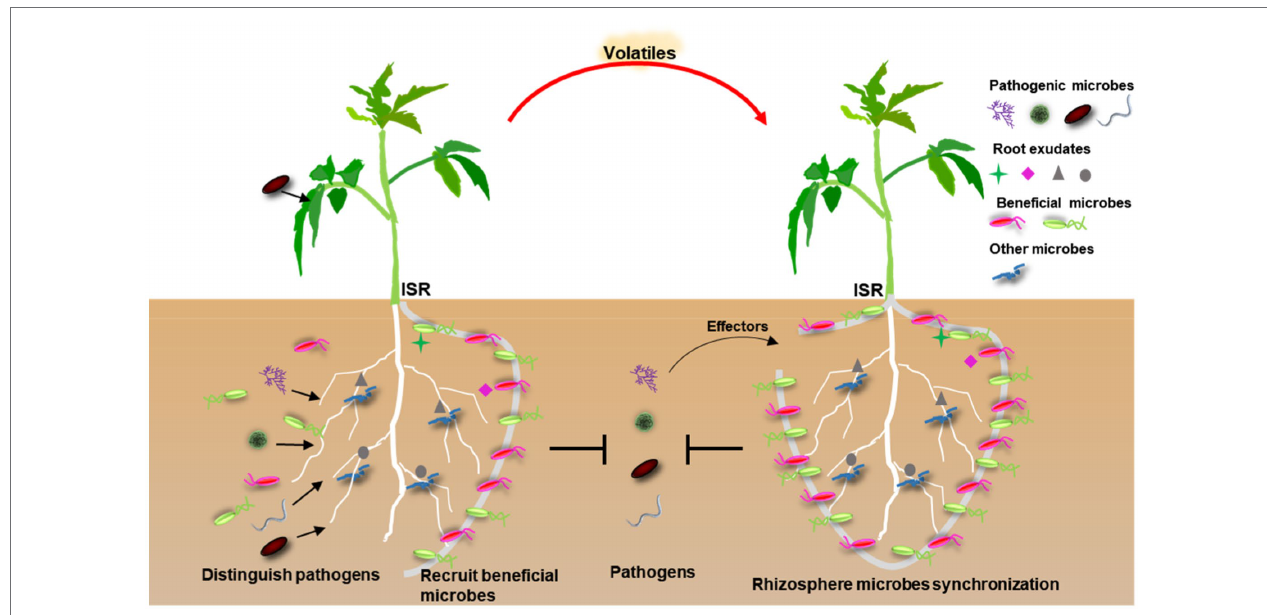
FIGURE 1 | A conceptual model of pathogen-mediated rhizosphere microbial recruitment for plant protection. First, the predecessor plants release root exudates into soil to manipulate soil microbial community dynamics or specifically recruit beneficial microbes after precisely recognizing pathogens invasion. The resulting microbial recruitments could effectively avoid excessive immune responses and then directly inhibit pathogens or induce systemic resistance (ISR). The surrounding plants possibly recruit rhizosphere microbiota through aerial signals (volatiles) from diseased plants. Successful pathogens use effectors, or other strategies, to break down the barrier formed by rhizosphere microbes for their